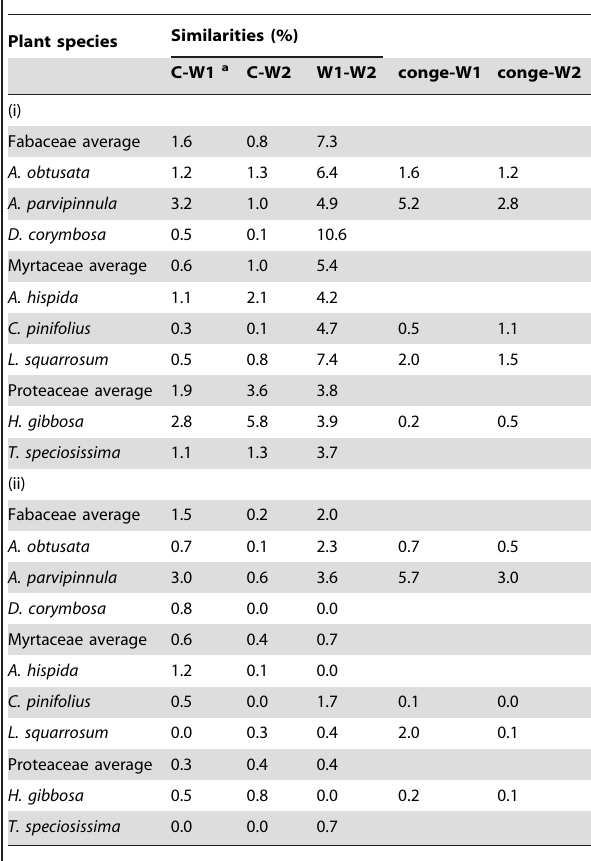
Table 1. Similarities (%) of Coleoptera and Hemiptera morphospecies from eight host plant species among transplant sites and congeneric plant species in the warm area, for (i) the full dataset and (ii) the herbivore